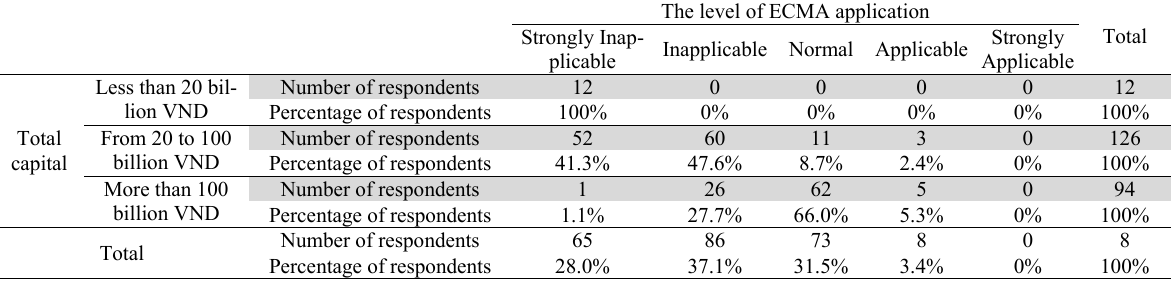
The level of ECMA application Inapplicable Normal Applicable plicable